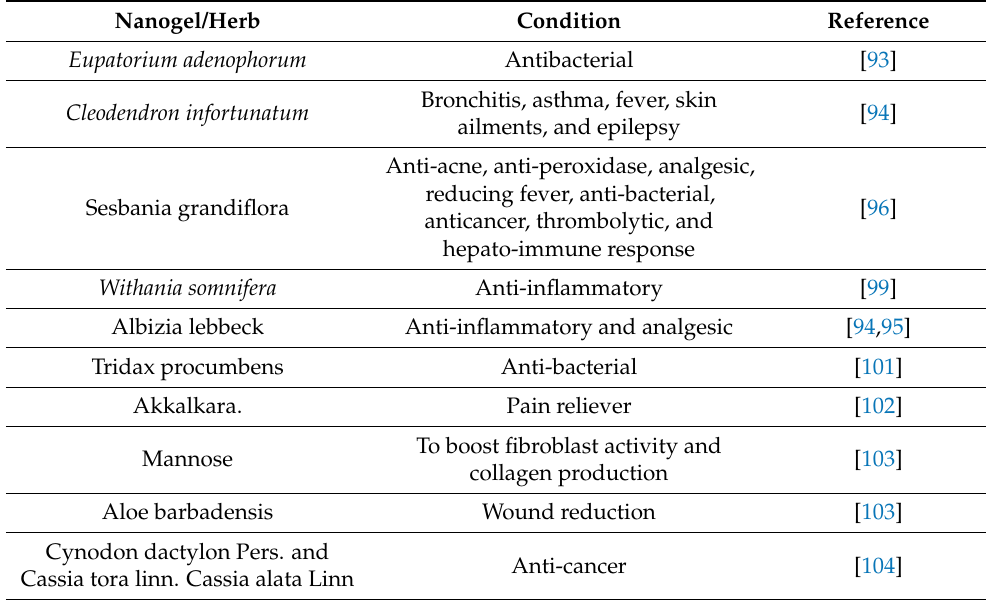
Table 2. Representative examples of some bioactive loaded